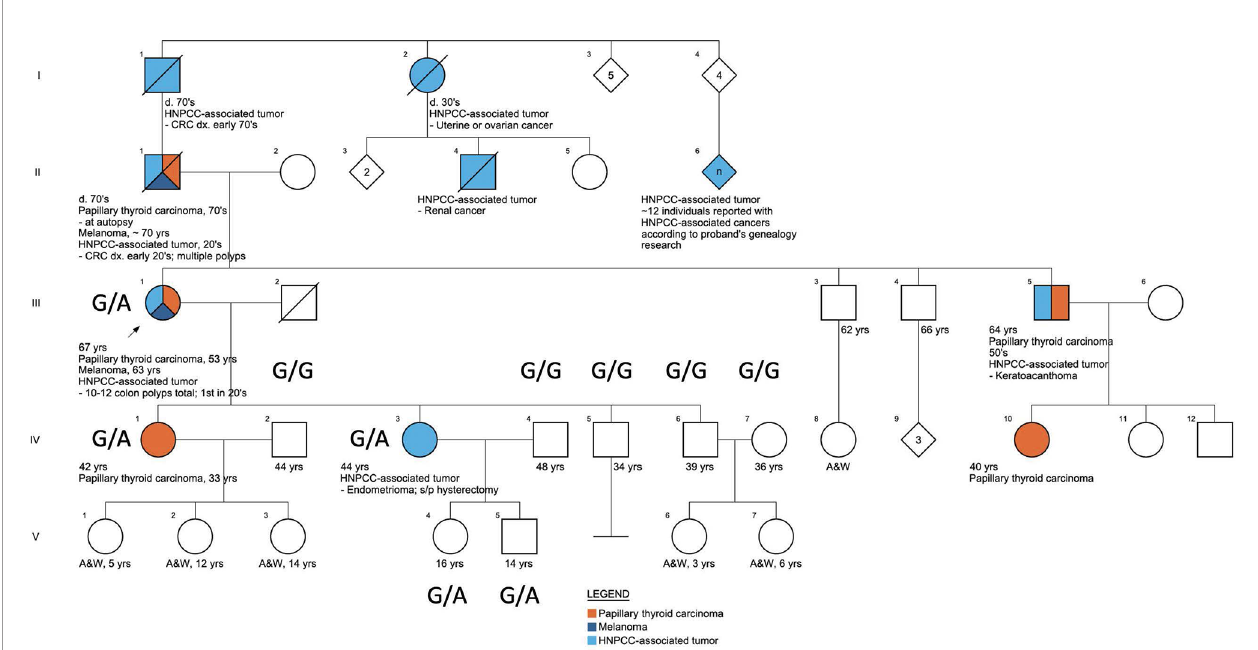
FIGURE 2 | The pedigree of the family characterized by the presence of FNMTC-HNPCC, associated tumors, and melanoma.